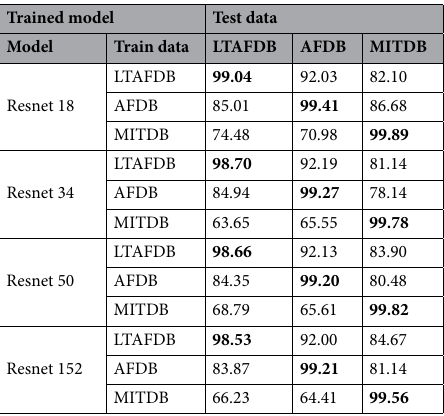
Table 3. Performance results of different Resnet models.